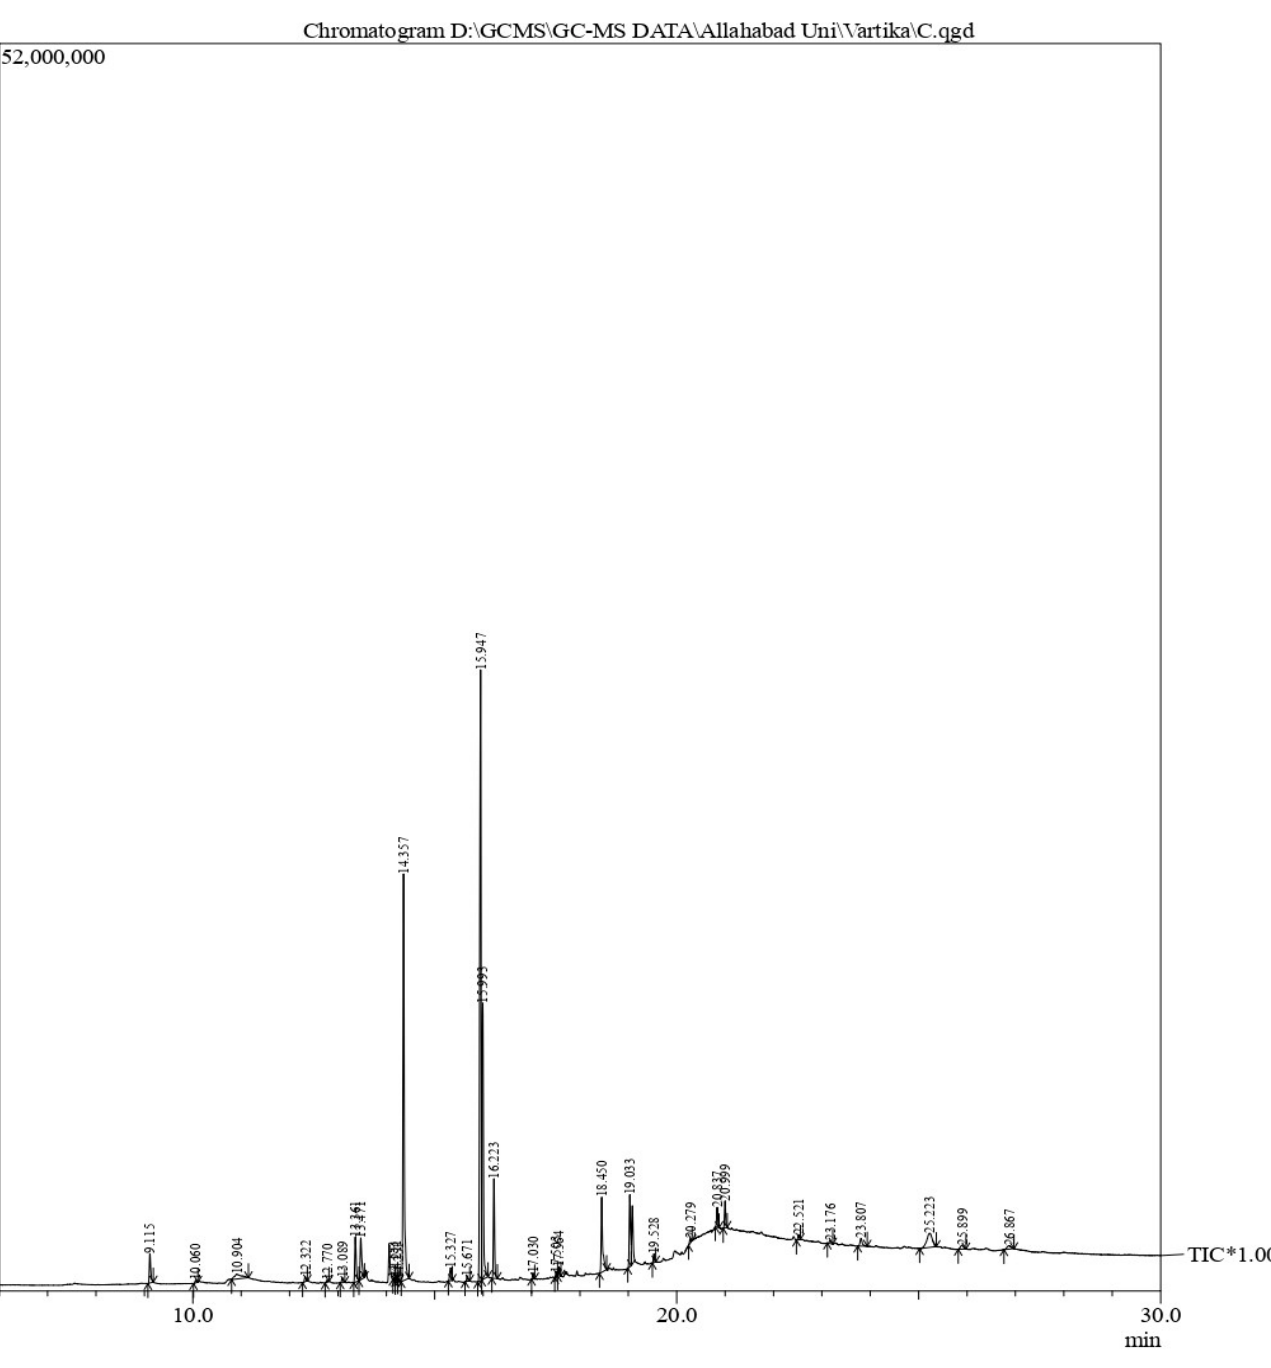
Figure 3. GC-MS chromatogram of the phytoconstituents present in the ethanol extract of Pleurotus ostreatus (EEPO).